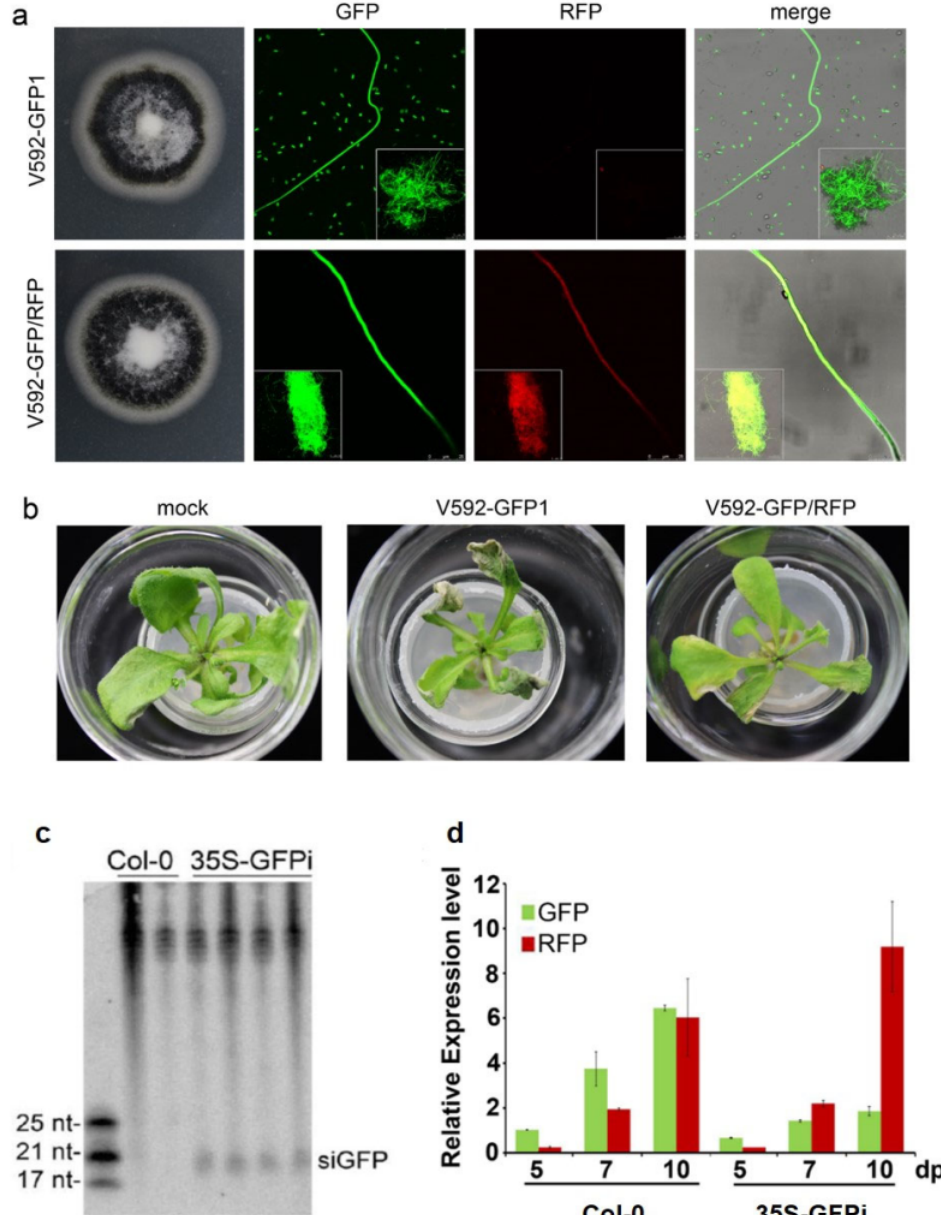
Figure 3. Examination of V592-GFP/RFP in 35S-GFPi transgenic Arabidopsis . ( a ) Colony morphologies and confocal microscopy images of hyphae of V592-GFP1 and V592-GFP/RFP. ( b ) Similar infectivity of V592-GFP1 and V592-GFP/RFP in Arabidopsis . Photographs were taken at 10 days postinoculation. ( c ) Detection of GFP-derived siRNAs (siGFP) in 35S-GFPi transgenic Arabidopsis . Total RNAs isolated from wild-type Col-0 and 4 individual transformants were loaded. The GFP-specific sequence was used as a probe. The upper unspecific bands visible in the top blot serve as the loading control. Positions of 17, 21, and 25 nt siRNAs are indicated. ( d ) Expression of GFP and RFP mRNAs in infected Col-0 and 35S-GFPi Arabidopsis . Total RNAs isolated from roots of ten infected plants at indicated VdELF1 (as the internal standard) levels. The value of GFP mRNA in V592-GFP/RFP-infected Col-0 was arbitrarily designated as 1. Error bars represent SD for three replicates. Reduced levels of GFP mRNA but not RFP mRNAs were detected in 35S-GFPi